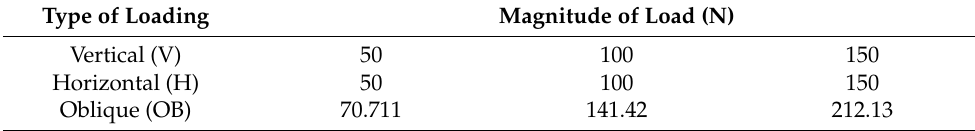
Table 3. Type of loading and magnitude.